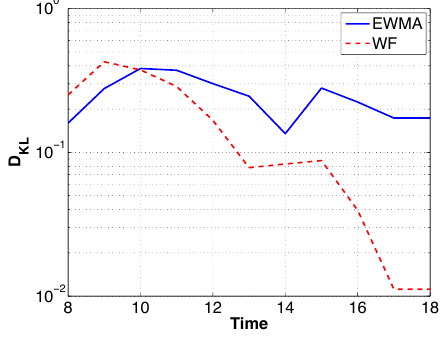
Figure 8. Empirical D KL